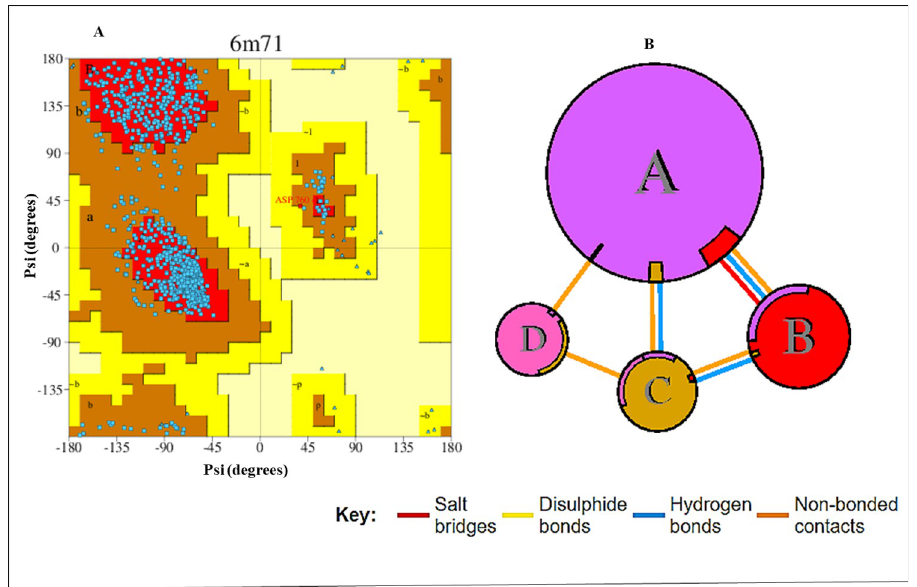
Fig 1. ( A ): Ramachandran plot. SARS-CoV-2 RdRp (pdb: 6M71) protein and ( B ): Interfaces summary of SARS-CoV- 2 RdRp (pdb: 6M71).